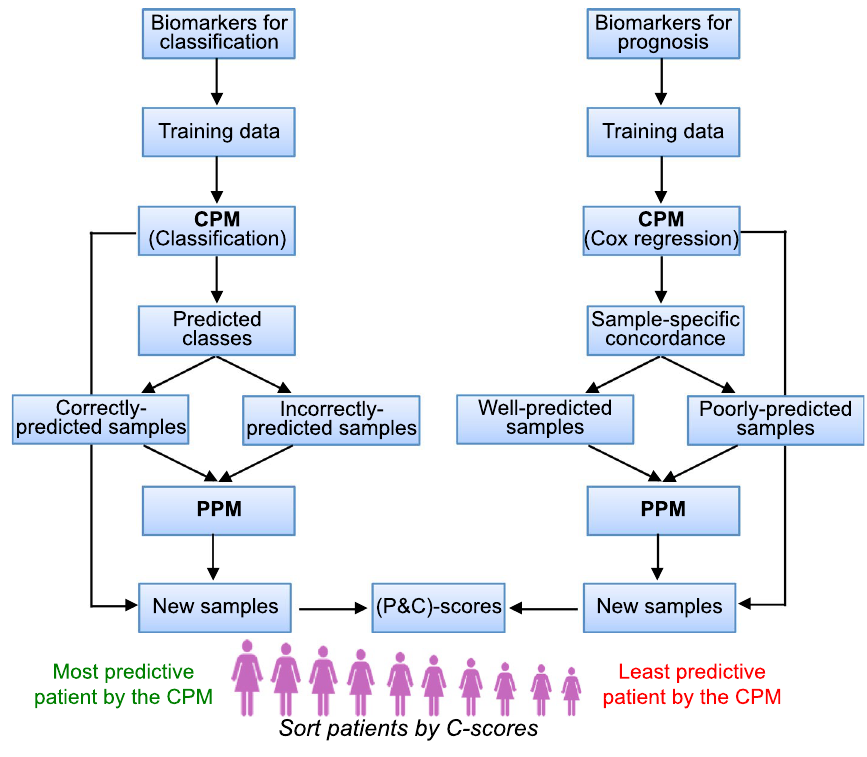
Figure 1. A schematic diagram of our framework for applying cancer biomarkers. Two models will be applied jointly to predict the clinical outcome of cancer patients and provide a confidence score of the prediction. The clinical outcomes of patients with higher confidence scores are more likely to be correctly predicted. This framework applies to classification (left side) and survival prediction (right side)